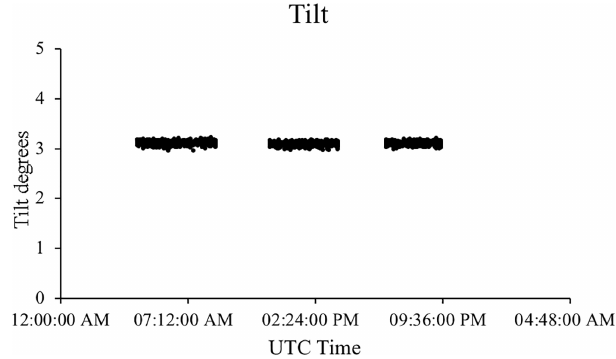
Figure Appendix A2. Time series of instrument tilt over the course of a deployment. Data are from the CFE-Cal 004 first deployment at location 4. Tilt averages about 3 ◦ , consistent with tilt reported for CFEs in Bishop et al. (2016).